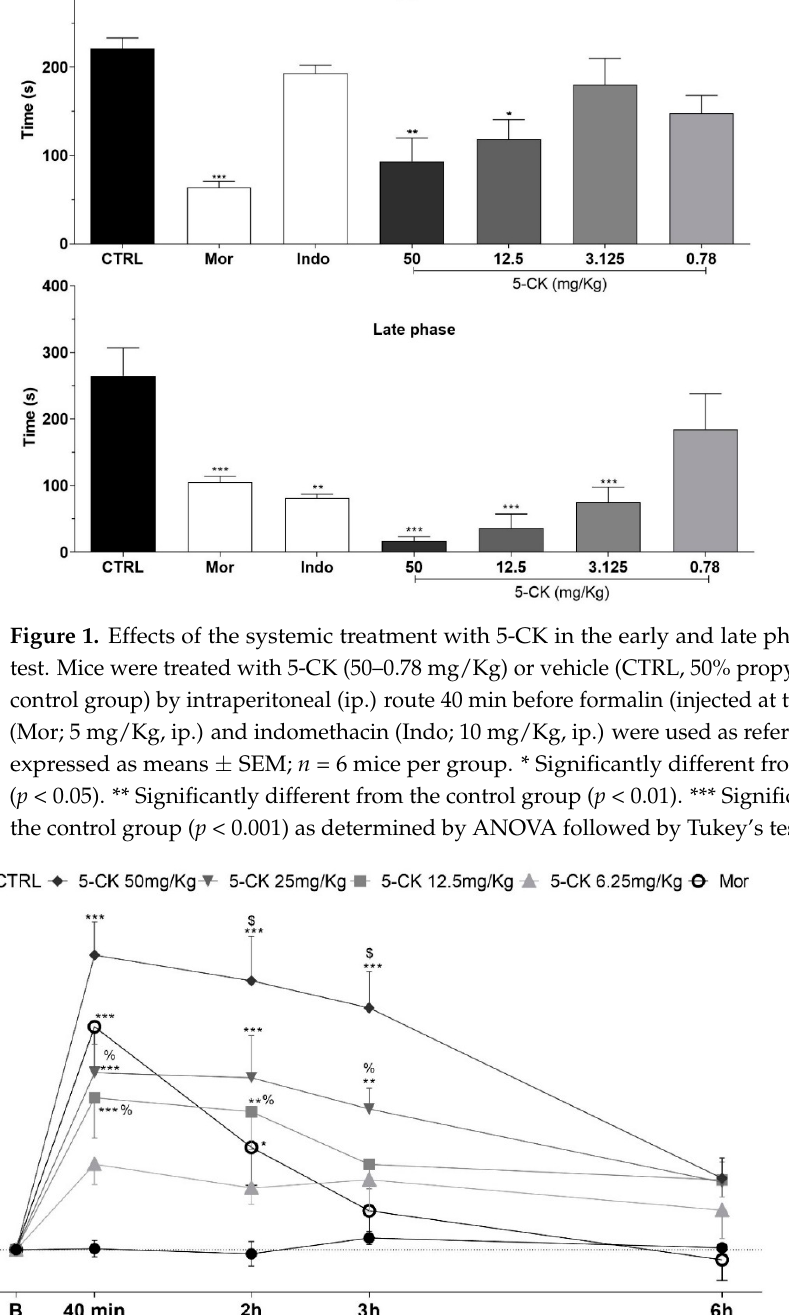
Figure 2. Antinociceptive effect of 5-CK on the tail flick test. Mice were treated by intraperitoneal (ip.) route 40 min before the test. For the dose − response analysis, the effects of increasing doses (6.25 to 50 mg/Kg) were tested. To evaluate the time-course of the antinociceptive effect, the thermal nociceptive threshold was measured before and up to 24 h following administration of 5-CK, vehicle (CTRL, 50% propylene glycol in saline; control group) or morphine (Mor; 5 mg/Kg, ip.), the reference drug. Data are expressed as mean ± SEM; n = 6 mice per group. $ Significantly different from morphine group ( p < 0.001) % Significantly different from 5-CK 50 mg/Kg group ( p < 0.05). * Significantly different from the control group ( p < 0.05). ** Significantly different from the control group ( p < 0.01). *** Significantly different from the control group ( p < 0.001). Two-way ANOVA followed by Bonferroni’s